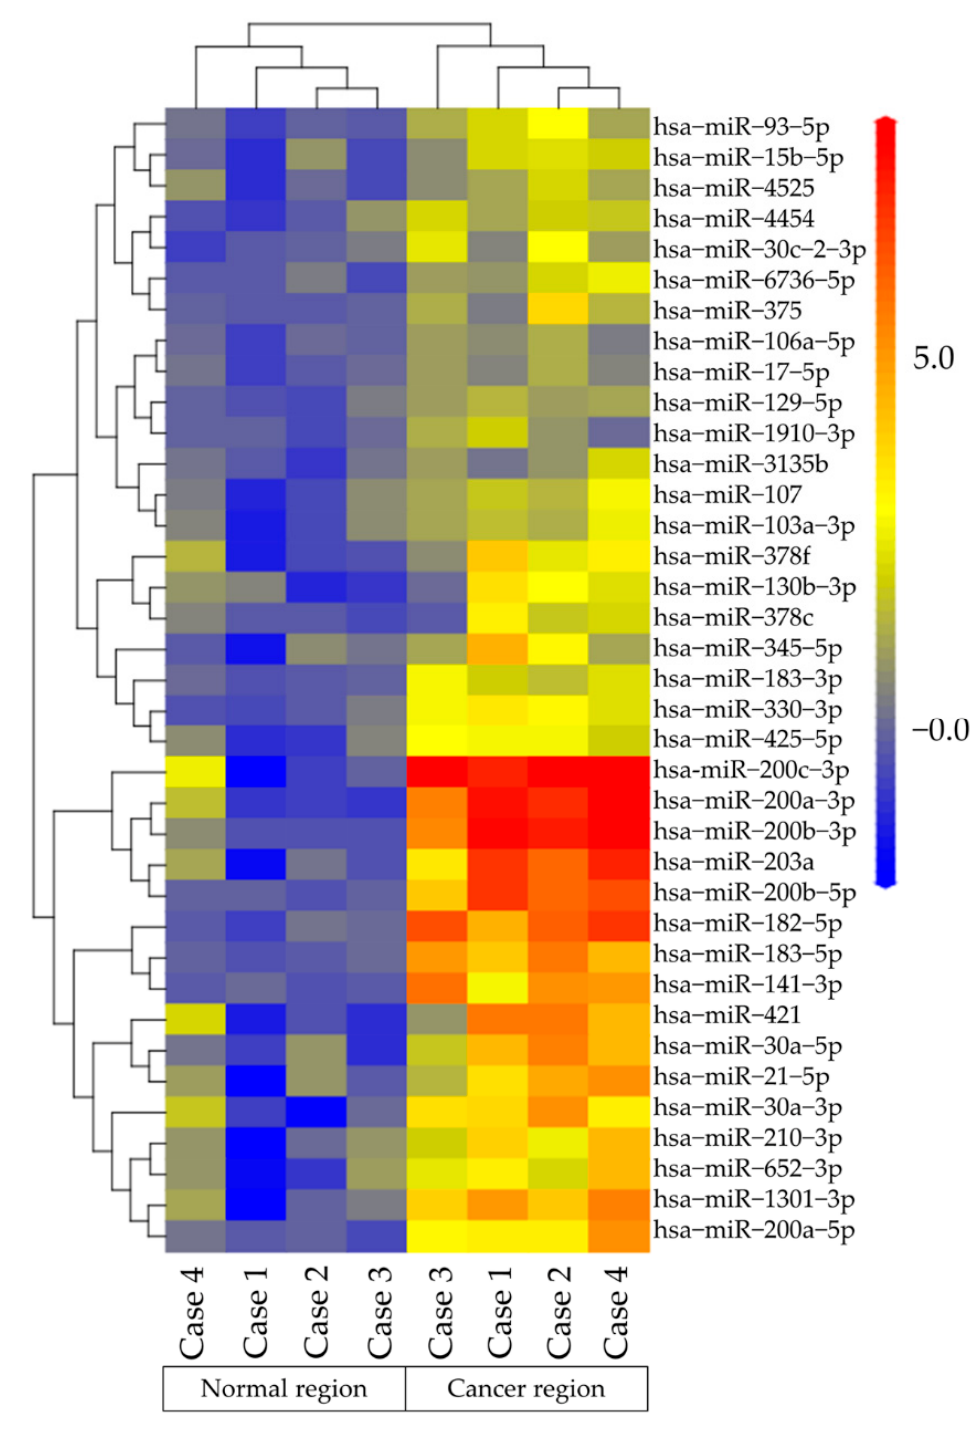
Figure 3. Heat map of the expression profiles of the 37 miRNAs based on microarray analysis in Te-EVs obtained from cancerous and normal tissues. The color scale is blue (low intensity), yellow (medium intensity), and red (high intensity).